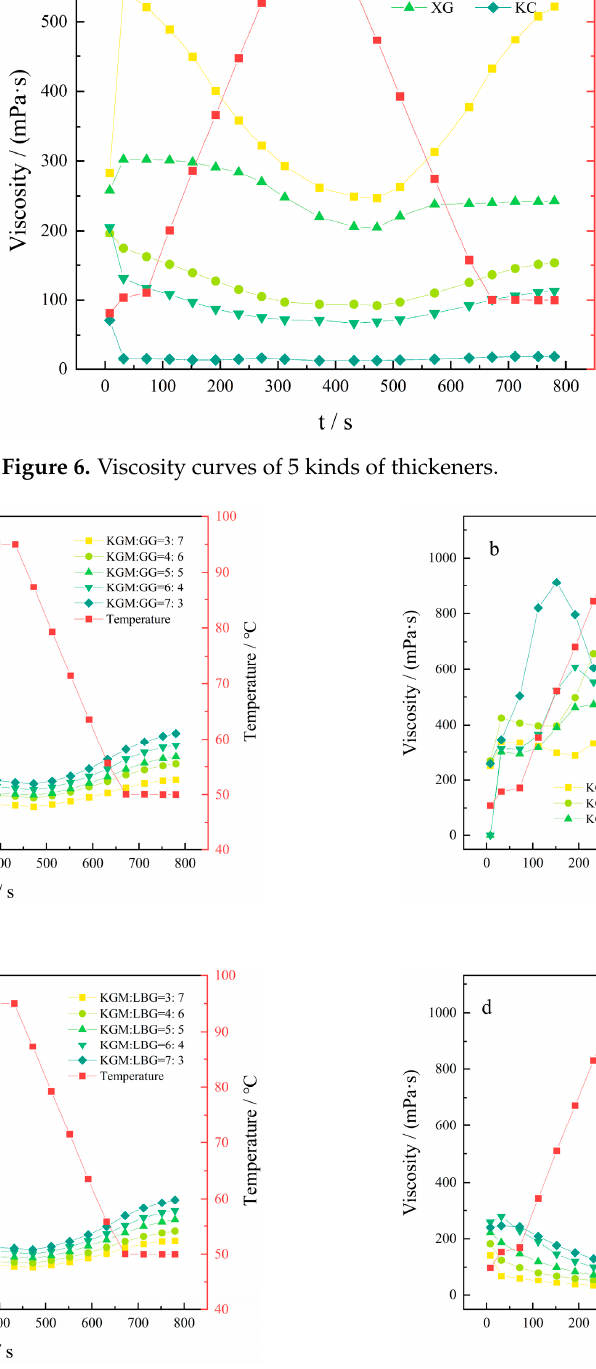
Figure 6. Viscosity curves of 5 kinds of thickeners.